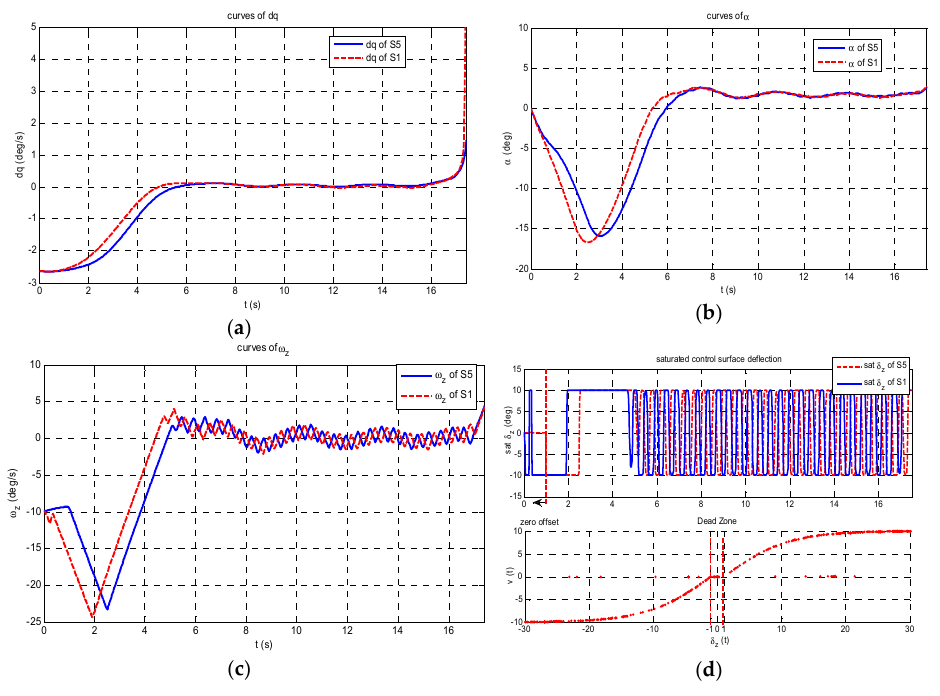
α ω . , ( c ) curves of z , and q , ( b ) curves of α , ( c ) curves of ω z , and ( d )